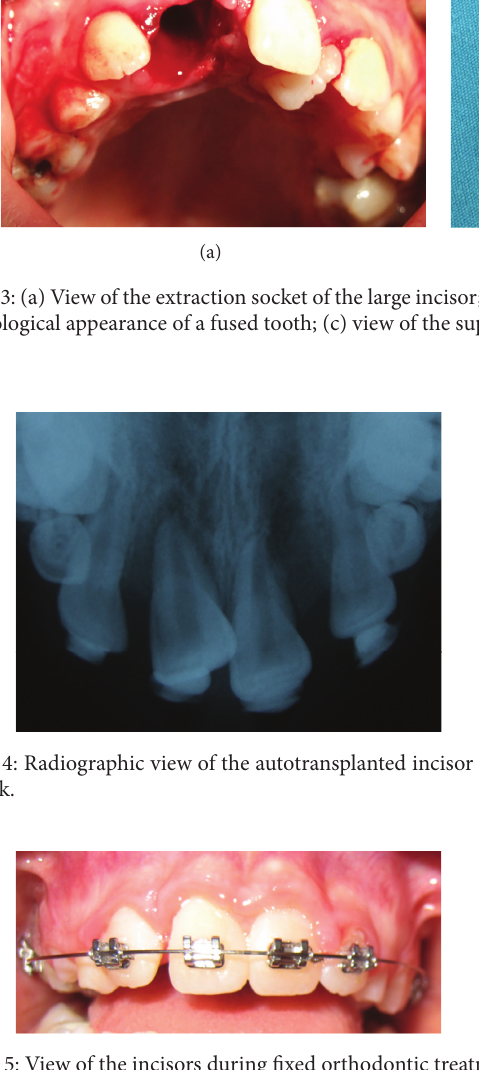
Figure 5: View of the incisors during fixed orthodontic treatment.